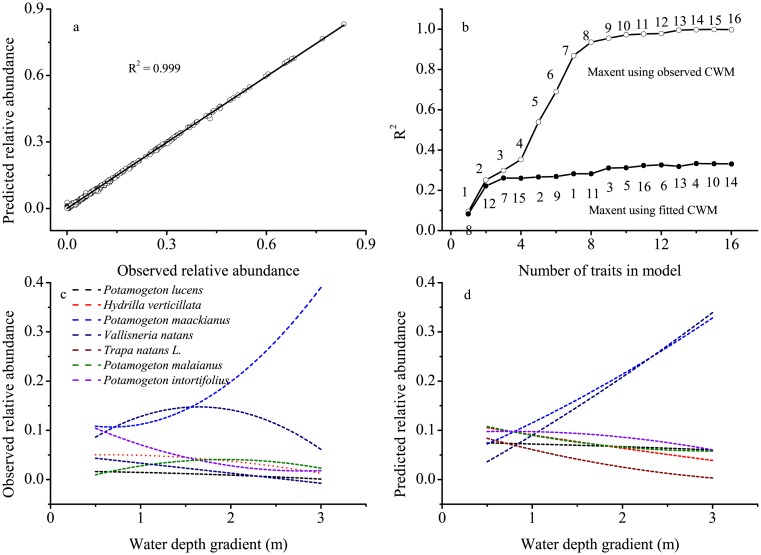
Results of a backward stepwise analysis of maximum entropy (maxent) model using community-weighted mean trait (CWM) constraints.(a) Observed vs. predicted relative abundances of 17 macrophyte species over 42 plots using observed sixteen CWM traits. (b) Relationship between the amount of explained variance of maxent model and the number of traits used in the model. Open circles represent models that used observed CWM traits as constraints, while filled circles represent models that used fitted CWM traits as constraints. Filled circles represent models in which traits were entered into the model in the order at which they are listed from left to right, based on how well they could be predicted from water depth gradient. The numeral codes showed in this chart indicates: 1-lamina thickness, 2-floating leaf, 3-perennial growth form, 4-rooting depth, 5-stem diameter, 6-tuber, 7-leaf nitrogen content, 8-stem dry mass content, 9-leaf dry mass content, 10-ramet size, 11-leaf carbon/nitrogen ratio, 12-leaf carbon content, 13-specific leaf area, 14-shoot height, 15-flowering duration, 16-mean Julian flowering dates. General linear models of observed (c) and predicted (d) relative abundances of seven common macrophyte species presented in Erhai Lake along water depth gradient. The predicted relative abundances used here were generated with the maxent model using the seven community-weighted mean trait constraints that were best predicted from water depth gradient.